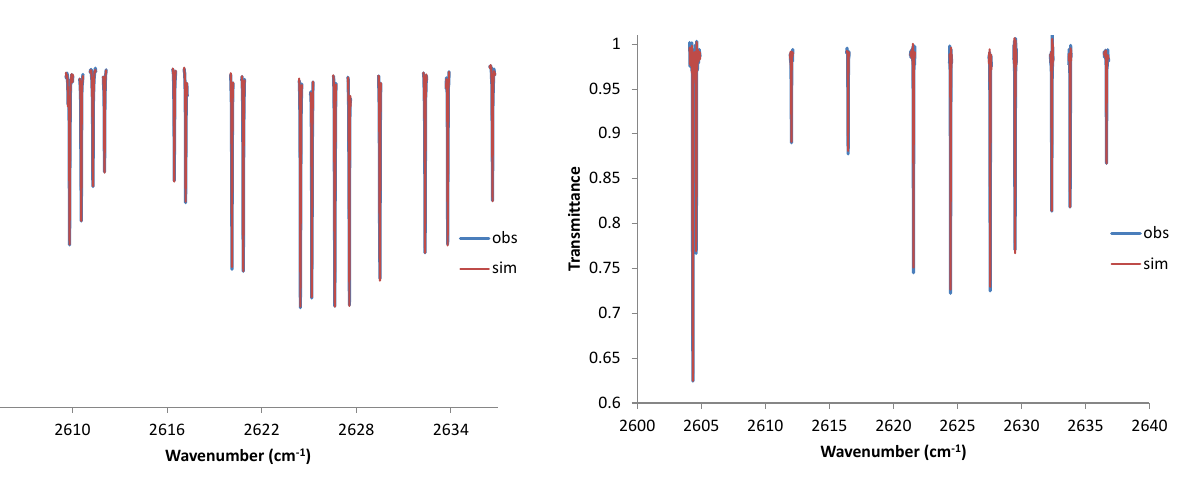
Figure 3c. Same as Fig. 3a, but for microwindows targeting lines in the 20002 ← 00001 band of 18 O 12 C 16 O.